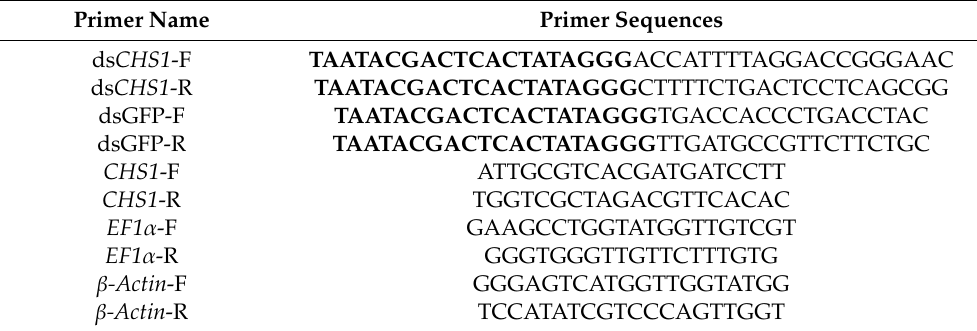
Table 1. The specific primers used in dsRNA synthesis and